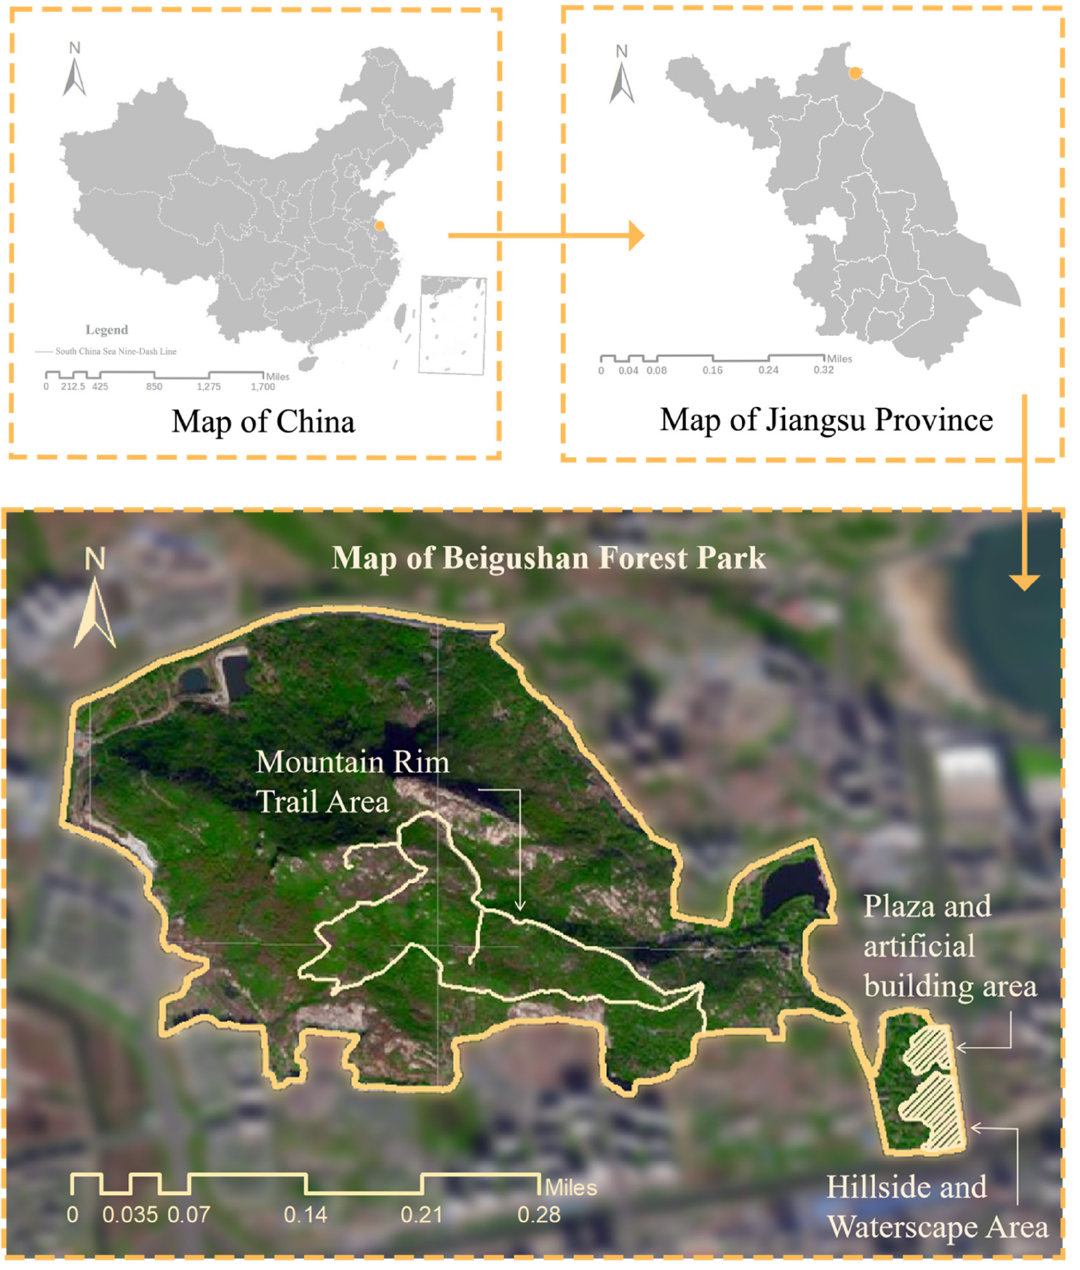
Figure 1. Geographical location of Beigushan Forest Park in Lianyungang.